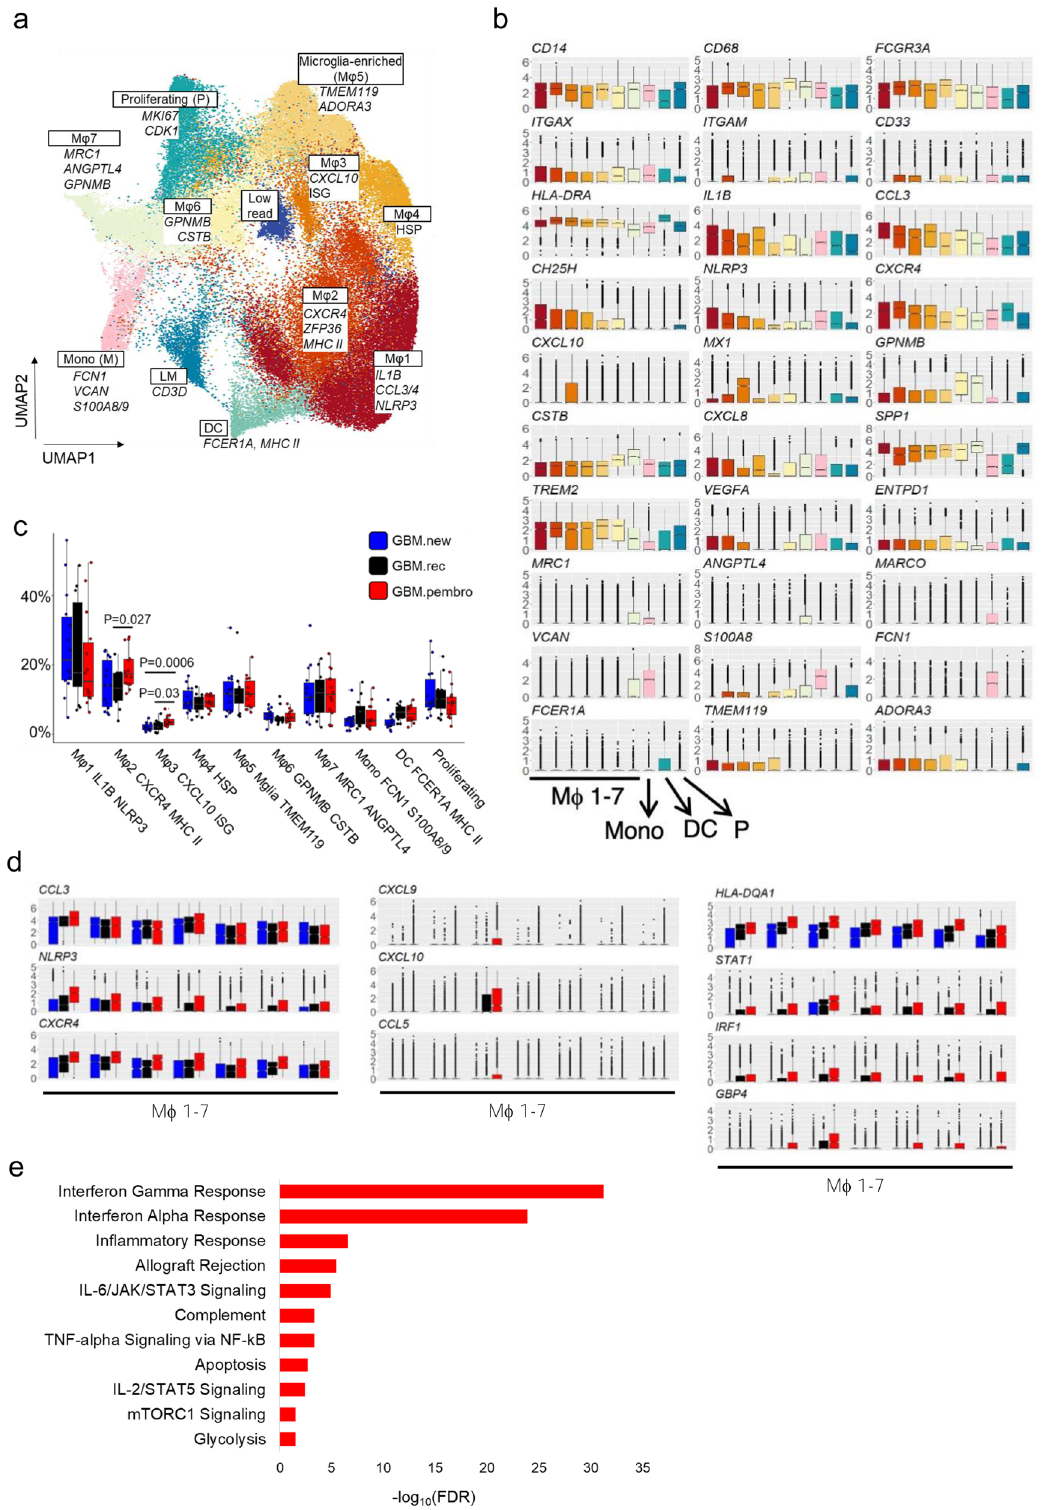
into solid tumors and involved with immunotherapy ef fi cacy 38 . The cells in the GBM.pembro group also showed increased expression of several macrophage in fl ammatory genes such as: NLRP3 , CH25H , CCL3/4 , and CXCR4 . In the CyTOF data analysis, we found a signi fi cant increase of CD274 (PD-L1) median expression and a concomitant increase in the percentage of PD-L1 + myeloid cells in the GBM.pembro